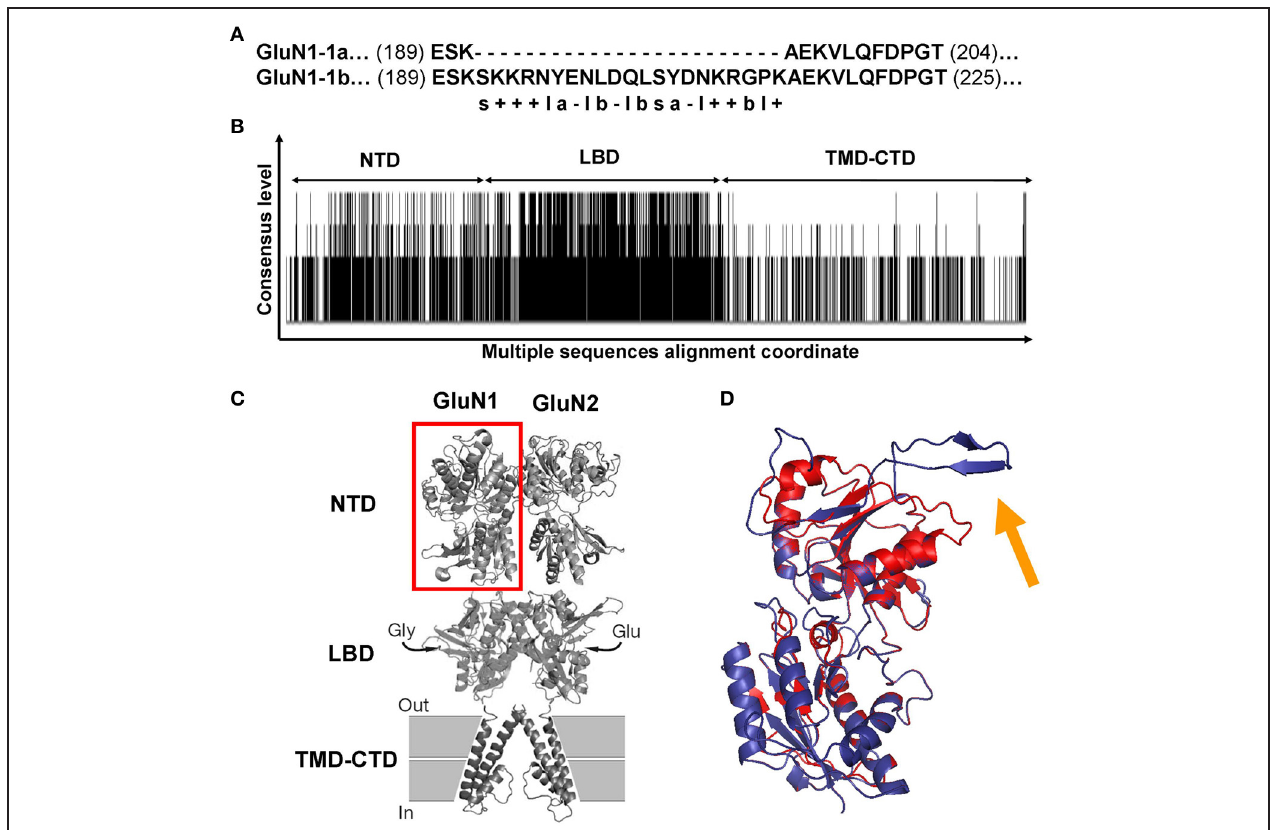
consensus level. As expected, the LBD is the most conserved. Blank areas represent the absence of sequence homology. (C) GluN1-GluN2 dimer model. Red square frame indicates GluN1 NTD. (D) Predicted GluN1 NTD tertiary structures. GluN1-1a (red) and GluN1-1b (blue) are superimposed. The orange arrow indicates the loop of the extra 21 amino acids of GluN1-1b. Note that this loop points away from the structure. The figure was created using PyMOL Molecular Graphics System, Version 1.2r3pre, Schrödinger, LLC. NTD, N-terminus domain; LBD, ligand binding domain; TMD-CTD, transmembrane domain and C-terminus